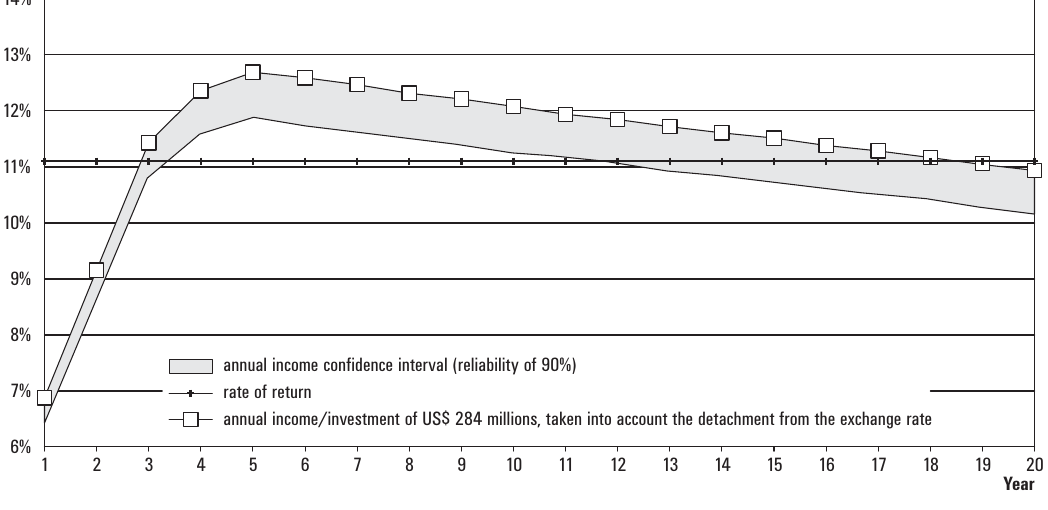
Figure 4. Yield curve, in US dollars with exchange rate